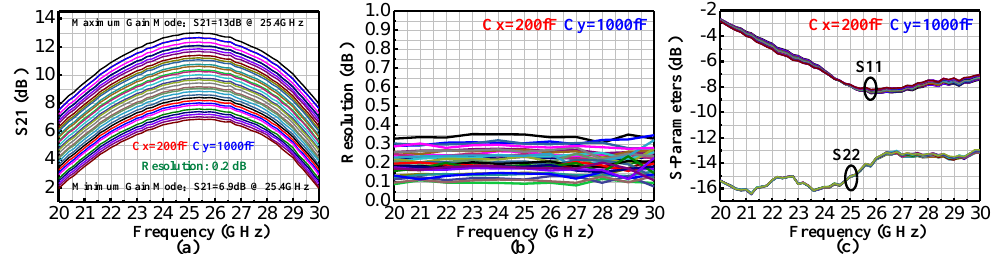
Figure 9. Based on C x = 200 fF, C y = 1000 fF (Ctr1 = 0 V, Ctr2 = 0 V): ( a ) measured 32 gain states versus frequency and ( b ) its corresponding 31 gain resolutions versus frequency; ( c ) measured S11 and S22 versus frequency at 32 control states.